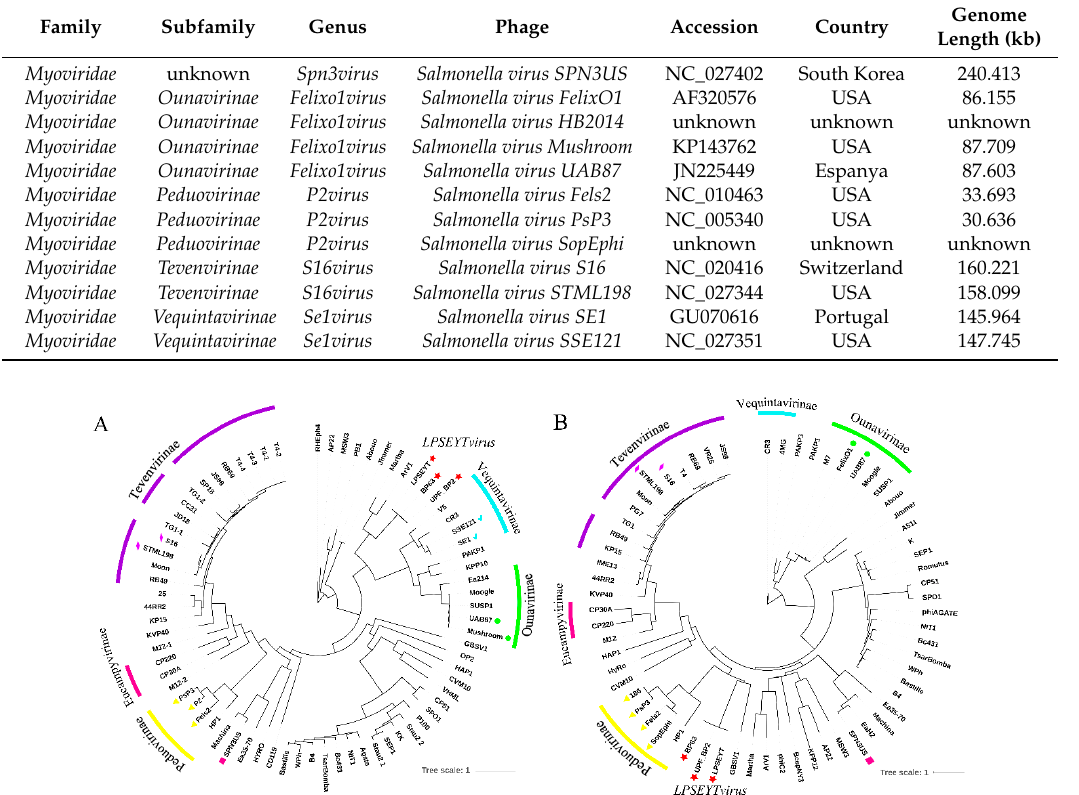
Table 4. Overview of International Committee on Taxonomy of Viruses (ICTV) recorded genus of Myoviridae that infect Salmonella Spp.